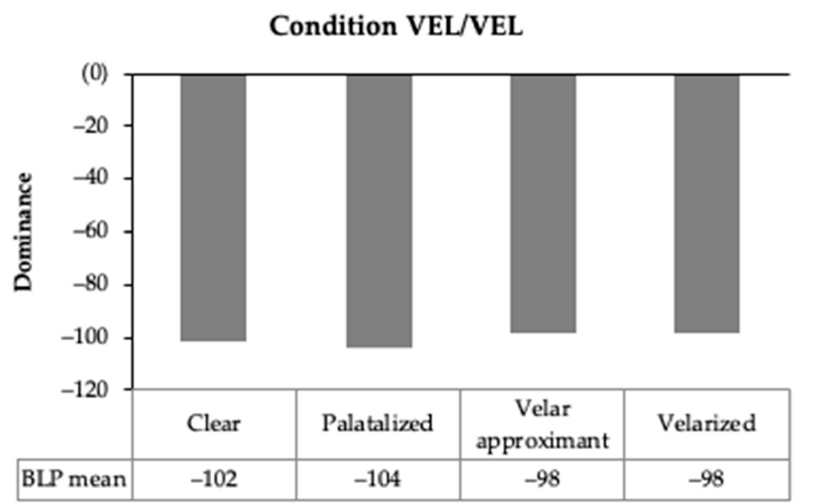
Figure 7. The interaction effect of condition VEL/VEL and language dominance.